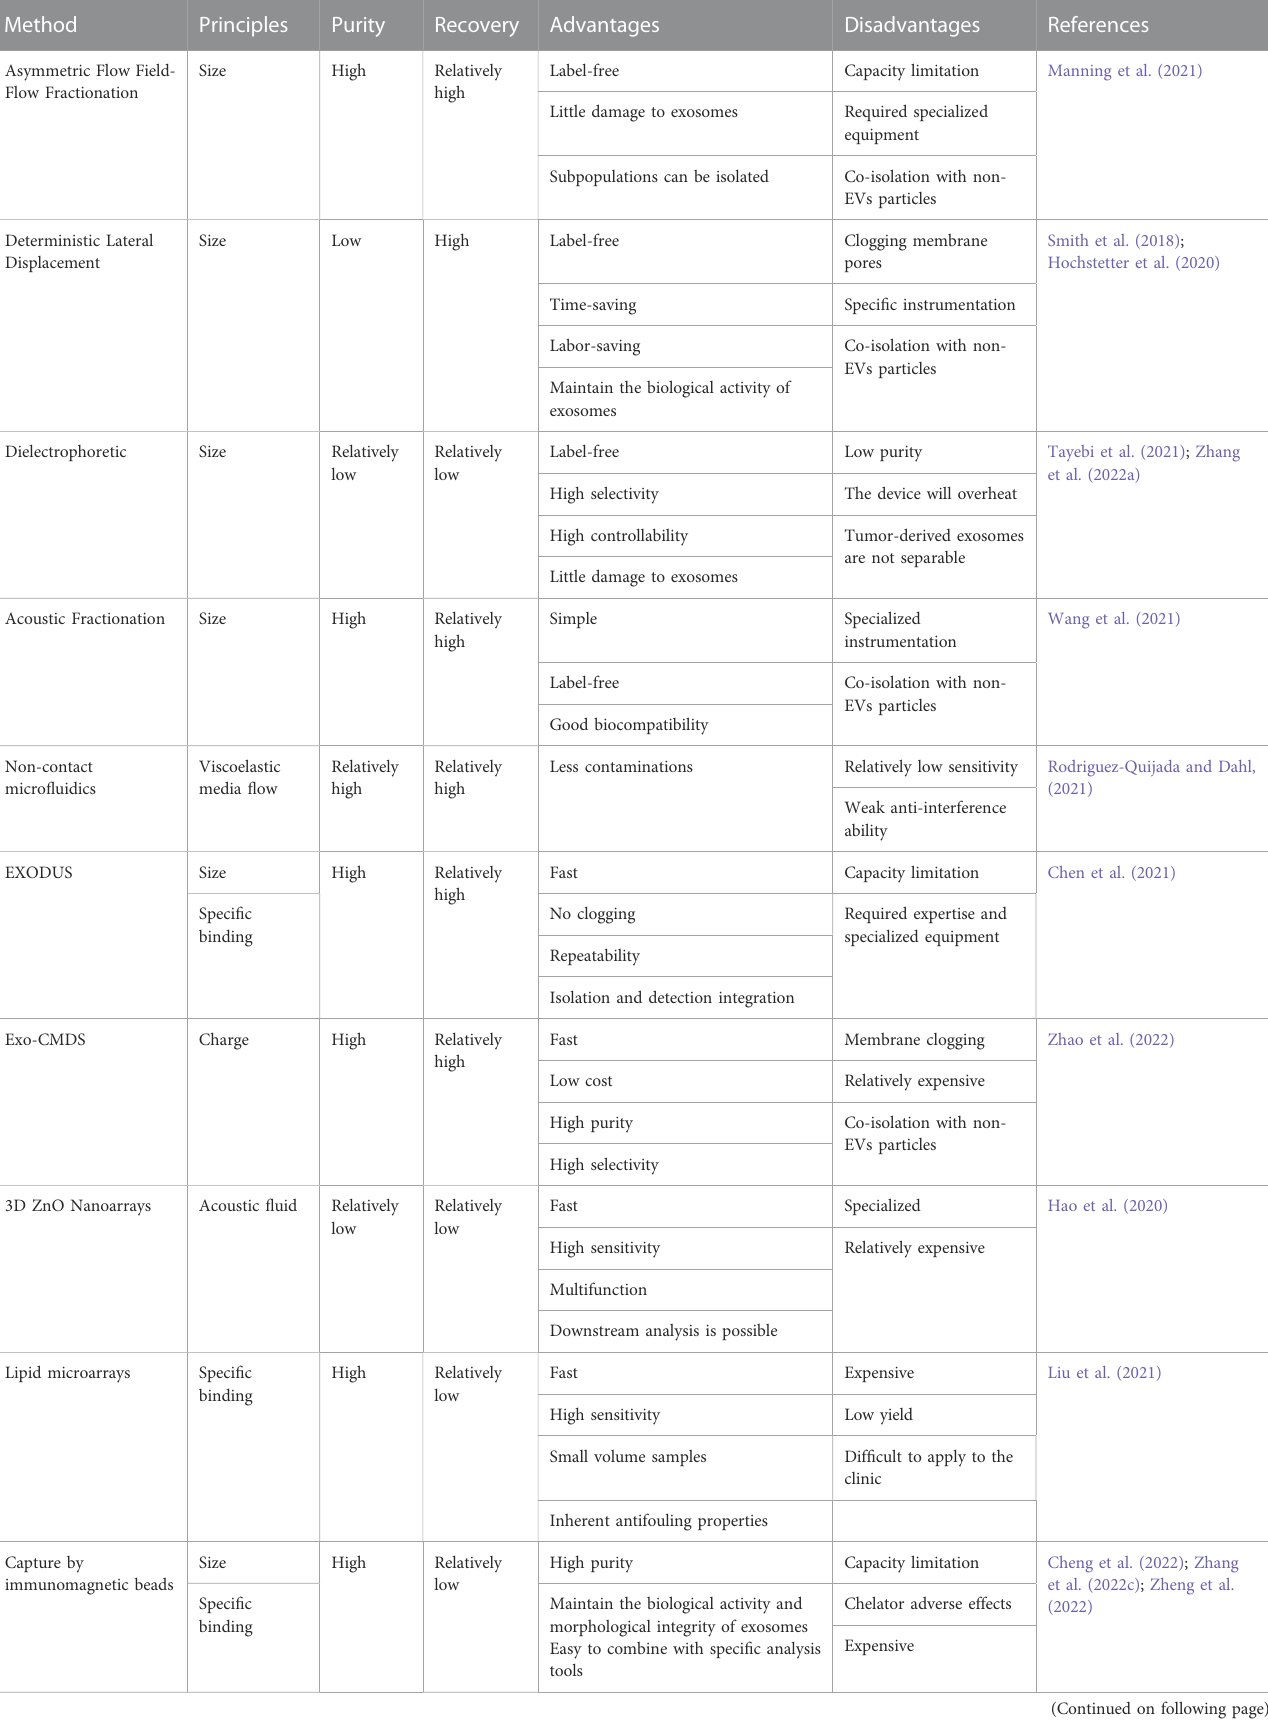
TABLE 2 Comparison of emerging isolation methods of